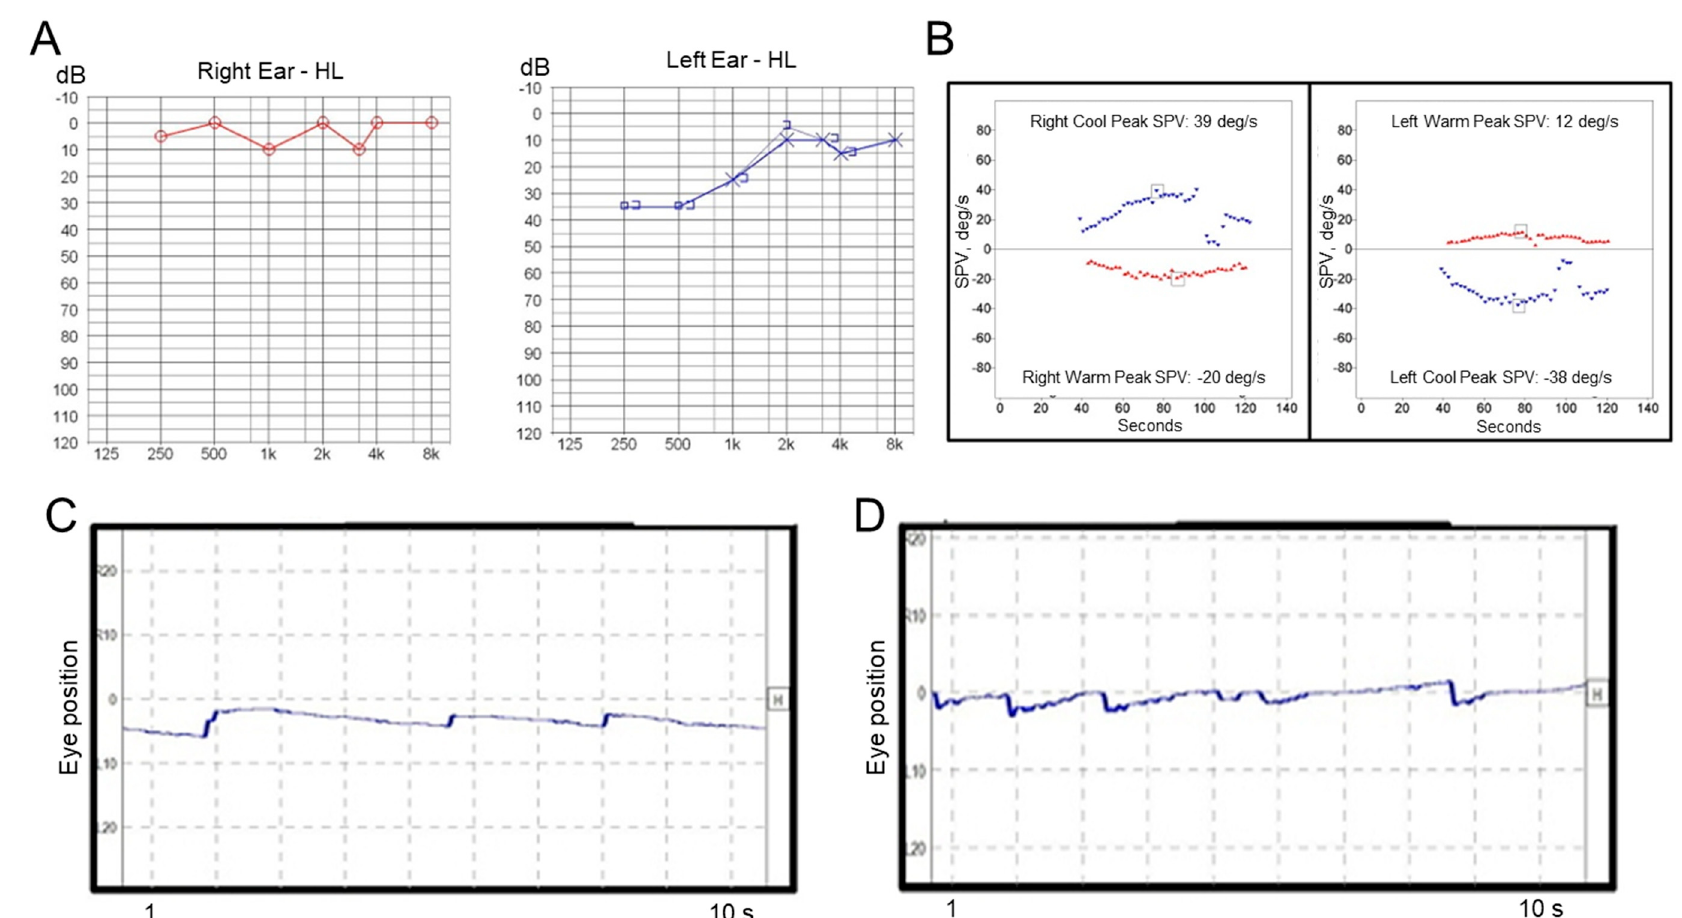
Figure 1. Results of laboratory tests in Case 1. ( A ) Pure tone audiometry shows low-frequency hearing loss on the left side. ( B ) A bithermal caloric test reveals canal paresis of 8% on the left side. Video-nystagmography demonstrates very weak right-beating nystagmus in the right head-roll position ( C ), and left-beating nystagmus in the left head-roll position ( D ).